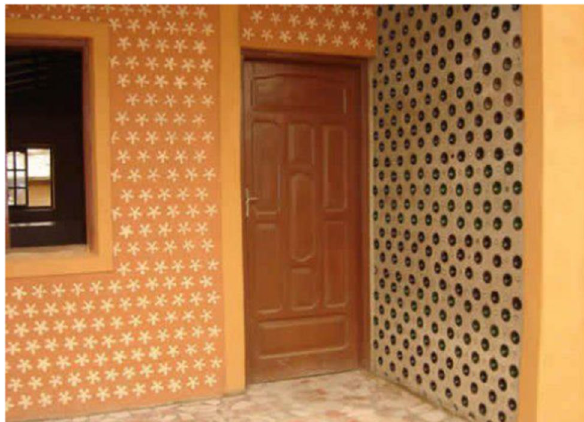
Fig. 3 Proposed process of valorisation of plastic waste into affordable housing